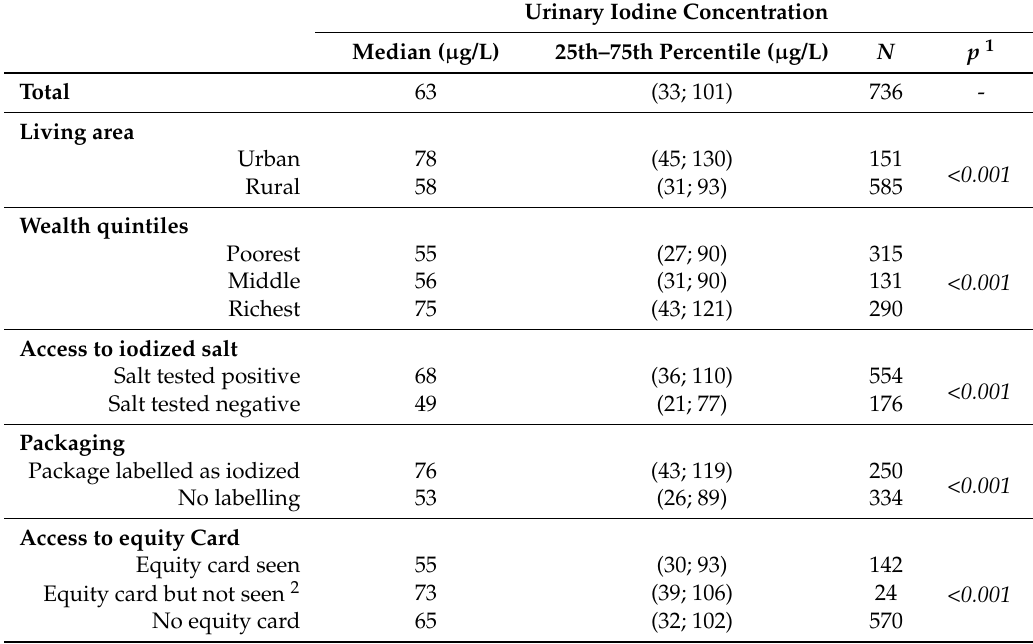
Table 1. Bivariate relationships between median urinary iodine concentrations (UIC) and living area, wealth quintiles, access to iodized salt, and access to equity card among